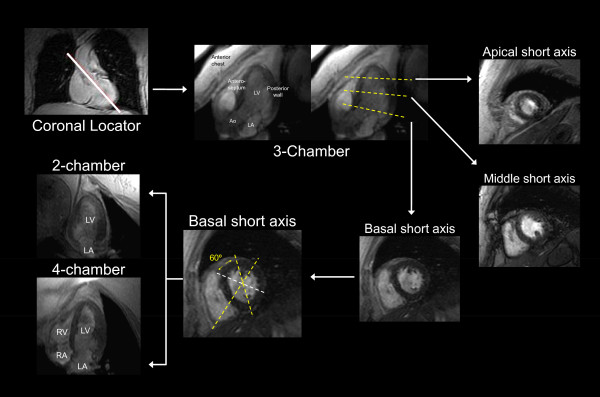
(Panel A): Myocardial segmentation during dobutamine stress CMR. Panel A: Strategy for obtaining 3 apical (3-chamber, 4-chamber, and 2-chamber) and 3 short-axis (basal, middle, and apical) cardiovascular magnetic resonance views of the left ventricle. On each image the myocardium is gray and the blood pool white. The white solid line on the coronal locator, and the white dotted lines on the 3-chamber view and basal short-axis view indicate the slice positions for obtaining the subsequent views demarcated by the white arrows.